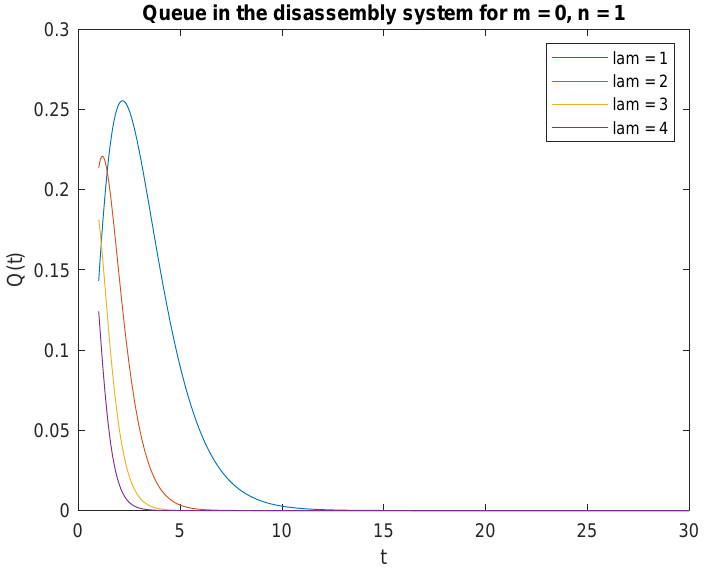
Figure 9. Impact of arrival rate on probability P { X ( t ) = m = 0 | X ( 0 ) = n = 1 } . Observe probabilities P { X ( t ) = 1 | X 0 = 0 } (Figure 10) and P { X ( t ) = 1 | X 0 = 1 } (Figure 11), the transient conditional distributions increase with decreasing